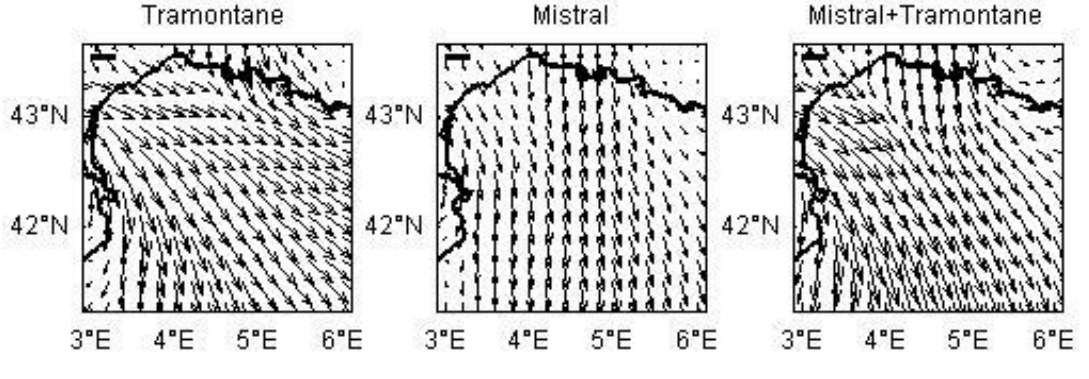
Figure 1. Three typical modeled wind fields over the GoL (model ALADIN of Météo France). They represent mixed situations of Mistral and Tramontane with, from left to right, dominant Tramontane, dominant Mistral and Tramontane and Mistral flowing with comparable intensies.